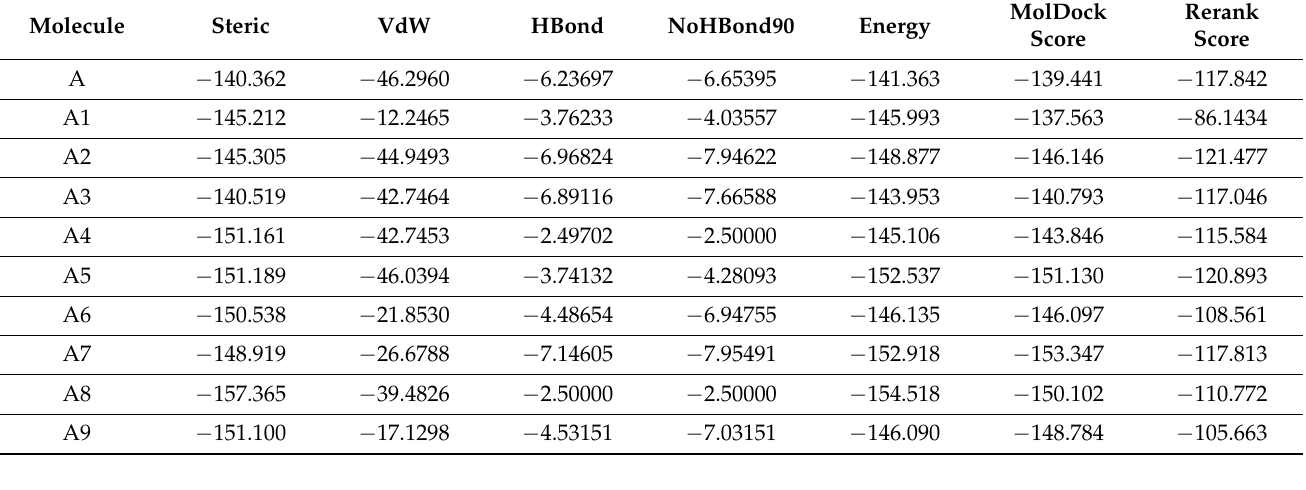
Table 4. Score values (kcal/mol) for all computer − aided designed compounds.